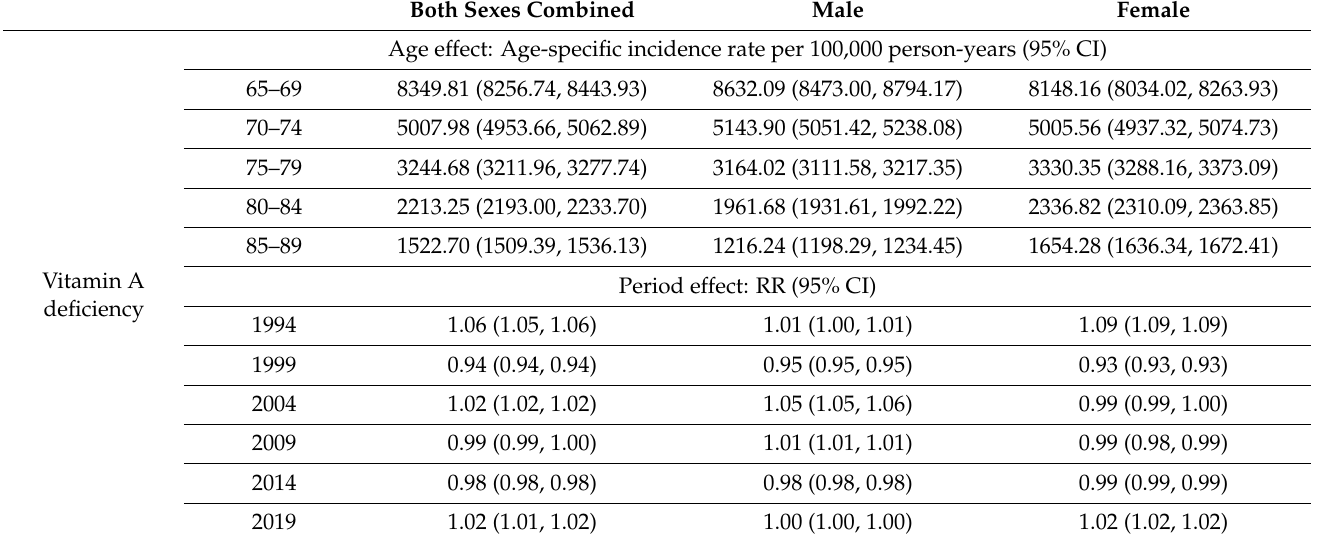
Table 1. The effect of age, period, and cohort on incidence of vitamin A deficiency, iodine deficiency, and protein-energy malnutrition among the elderly in China from 1990 to 2019, as stratified by sex. Both Sexes Combined Male